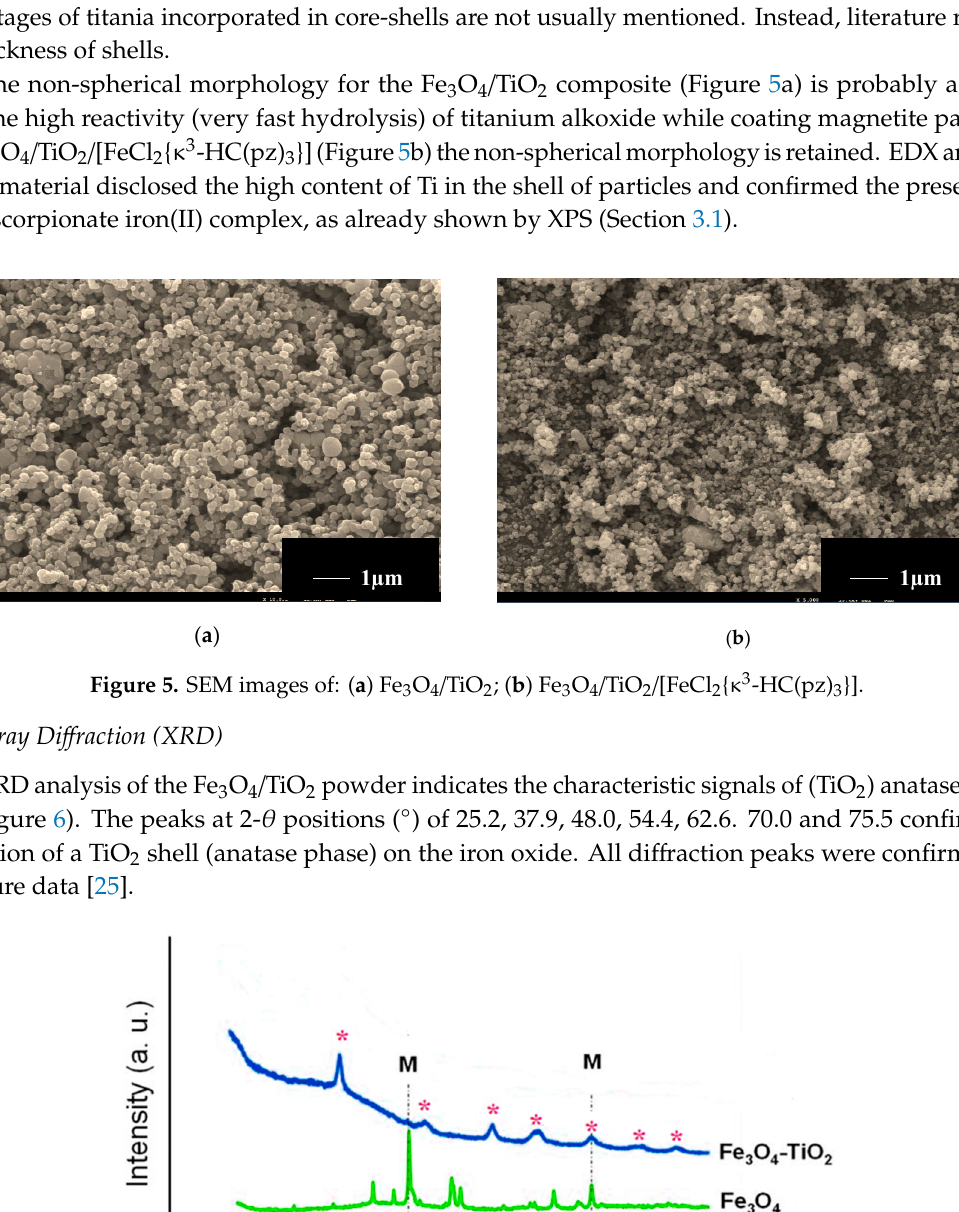
Figure 9. SEM images of magnetic core-shell Fe 3 O 4 /TiO 2 /[FeCl 2 { κ 3 - HC(pz) 3 }]: ( a ) after reaction under conventional thermal heating; ( b ) after reaction under microwave irradiation. Figure 6. X-ray di ff raction profiles of Fe 3 O 4 / TiO 2 core-shell and its comparison with the industrial Figure 6. X-ray diffraction profiles of Fe 3 O4/TiO 2 core-shell and its comparison with the industrial magnetite-rich powder; * is anatase (TiO 2 ) and M is Fe 3 O 4 magnetite-rich powder; * is anatase (TiO 2 ) and M is Fe 3 O 4 .